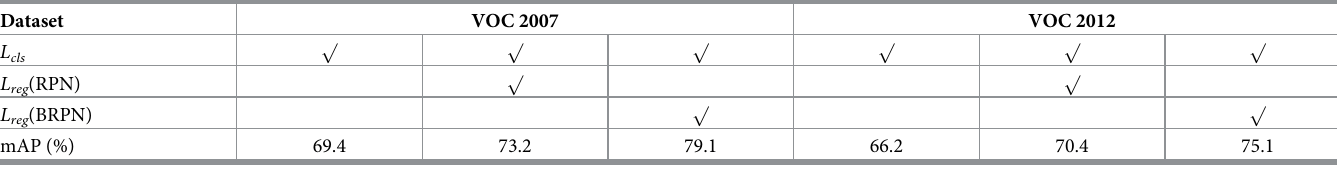
Table 10. Experimental results over the novel loss function optimized by the GWO.